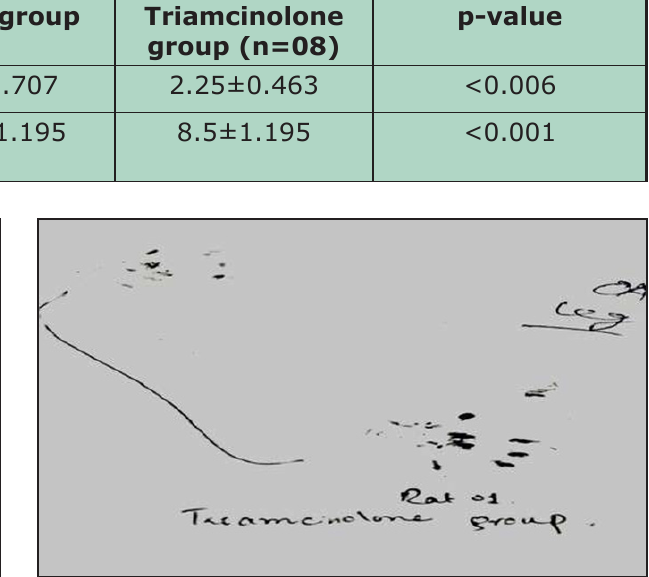
Table-I: Demographics and intergroup comparison of group-I (control group) and group-II (triamcinolone group).